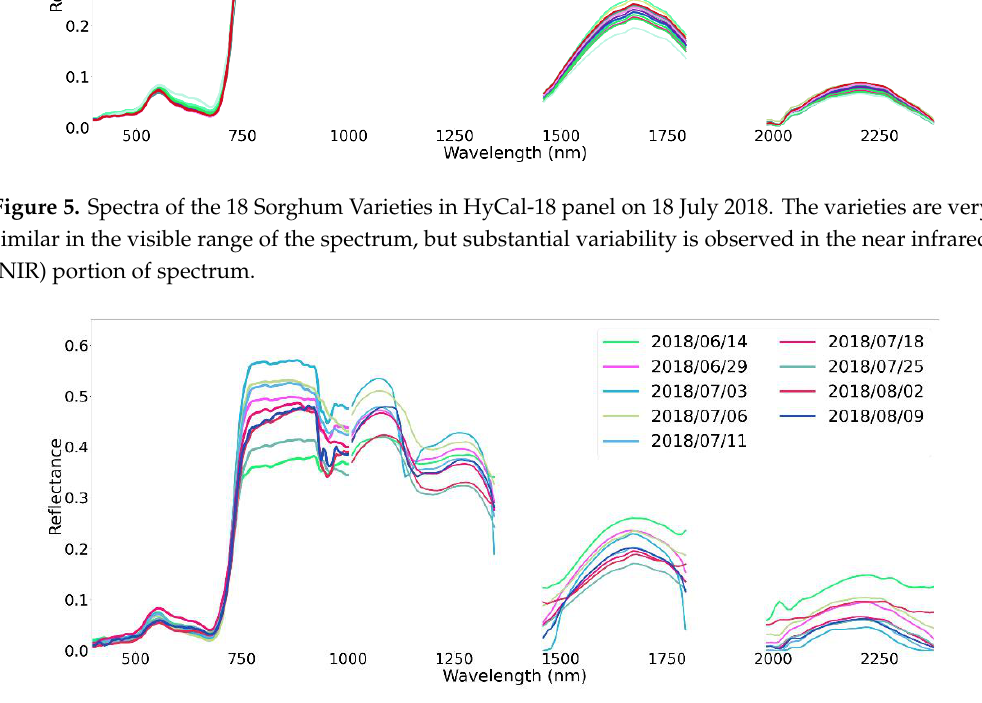
Figure 6. Example of reflectance of one of the varieties in HyCal-18 experiment (“Trudan 8”) during the 2018 growing season.